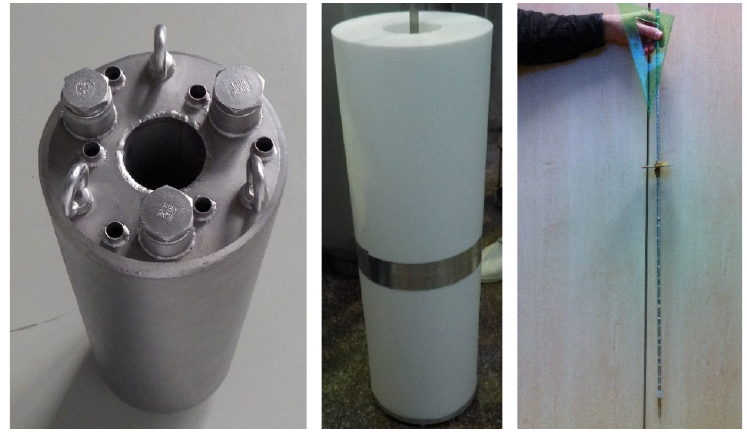
Figure 2. From the left: FLIBE module, Teflon module, activation foil carrier.